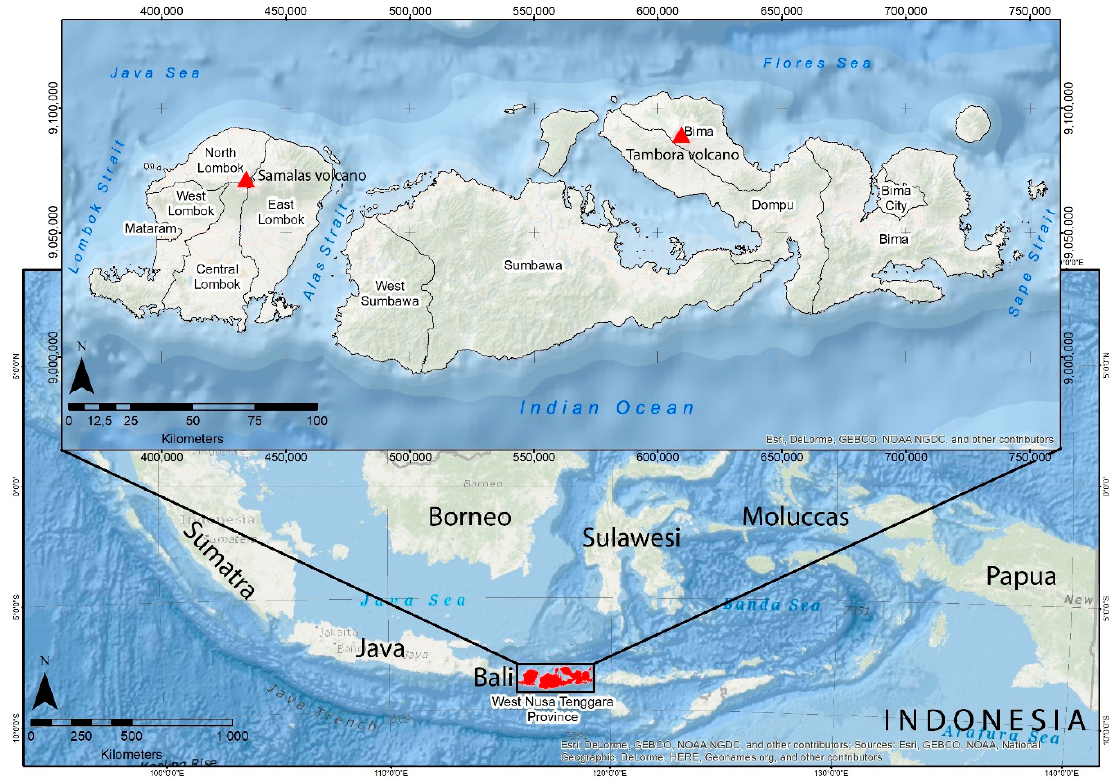
Figure 1. Lombok and Sumbawa Island in the inner arc of the Lesser Sunda Islands.